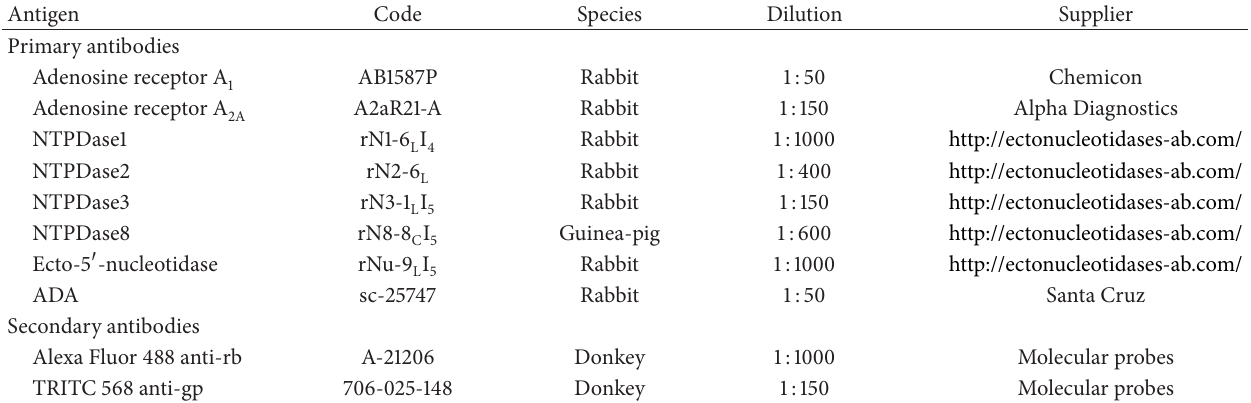
Table 1: Primary and secondary antibodies used in immunohistochemistry